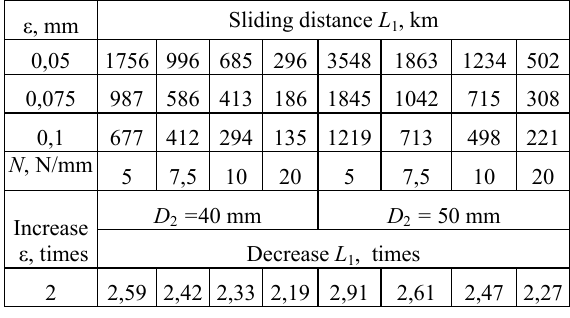
Table 2. Guide resource L 1(DK) for a bushing made of DK6 ε ,